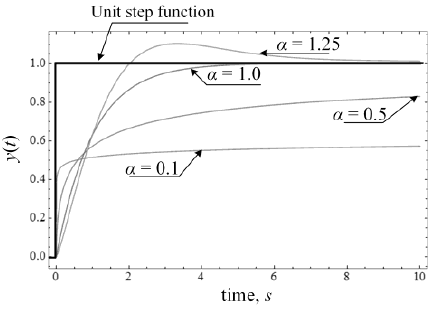
Fig. 4. Fractional-order filter step responses.